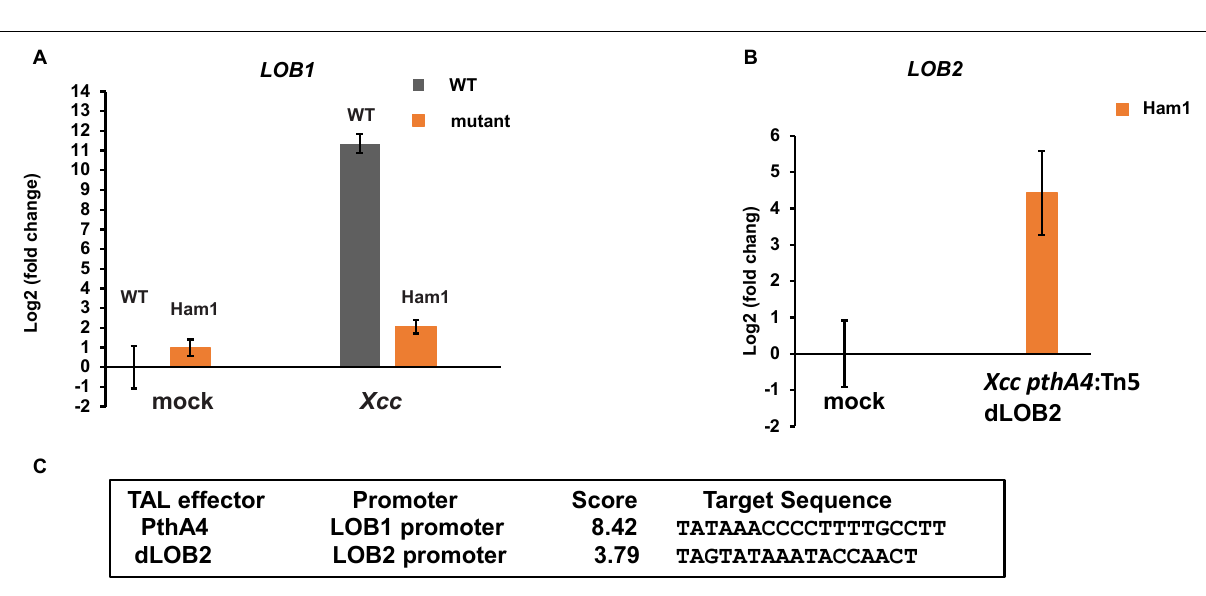
Frontiers in Plant Science |